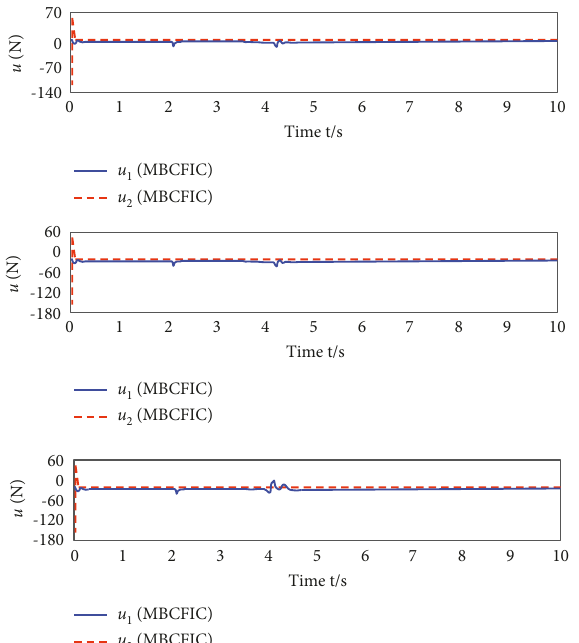
Figure 7: Control input curves of three control